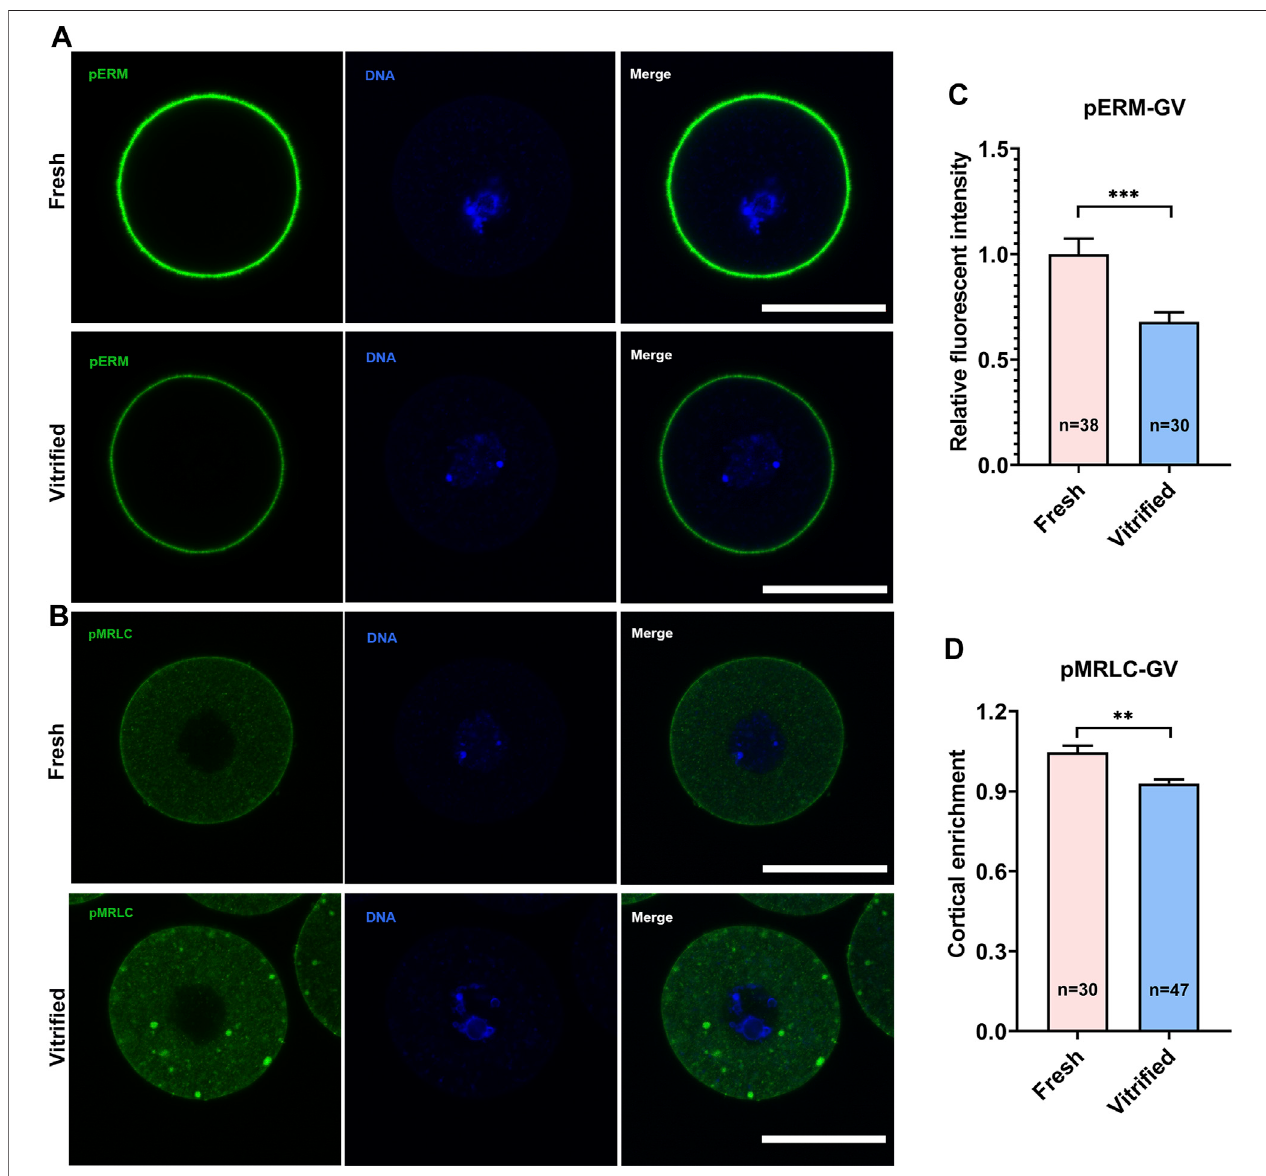
FIGURE 1 | Vitri fi cation induced a signi fi cant decline in cortical tension in GV oocytes. (A) Representative images of pERM staining in GV oocytes. Scale bar = 50 μ m. (B) Representative images of pMRLC staining in GV oocytes. Scale bar = 50 μ m. (C) Quanti fi cation of the relative pERM fl uorescence intensity in fresh ( n = 38) and vitri fi ed ( n = 30) GV oocytes. (D) Quanti fi cation of the ratio of cortical to cytoplasm pMRLC fl uorescence intensity in fresh ( n = 30) and vitri fi ed ( n = 47) GV oocytes. Data were presented as mean percentage (mean ± SEM) of at least three independent experiments. * p < 0.05, ** p < 0.01, *** p < 0.001.